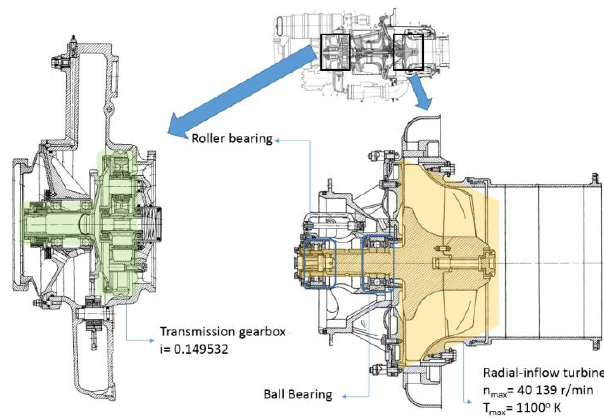
Figure 4. Cross-section of the TA-8V engine (Adapted from [19]).